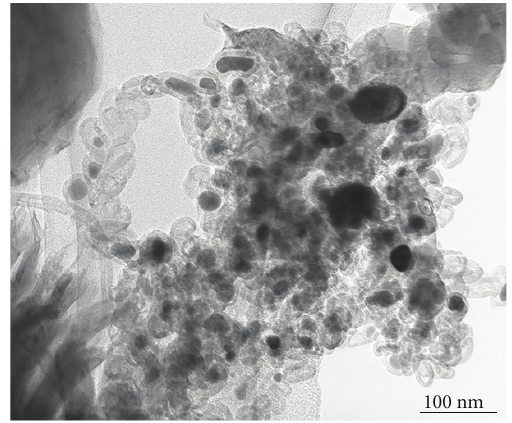
Figure 4: Bright-field image of carbon nanocapsules and carbon nanotubes in heat-treated specimen.